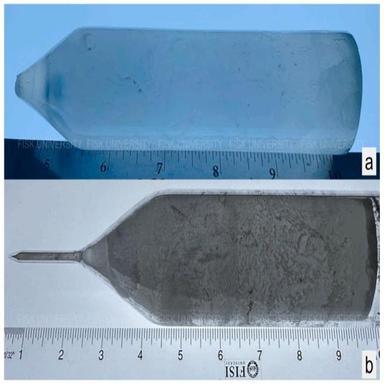
Examples of the latest (a) ∅1.5-inch and (b) ∅2-inch TLYC single crystal boules grown at Fisk.